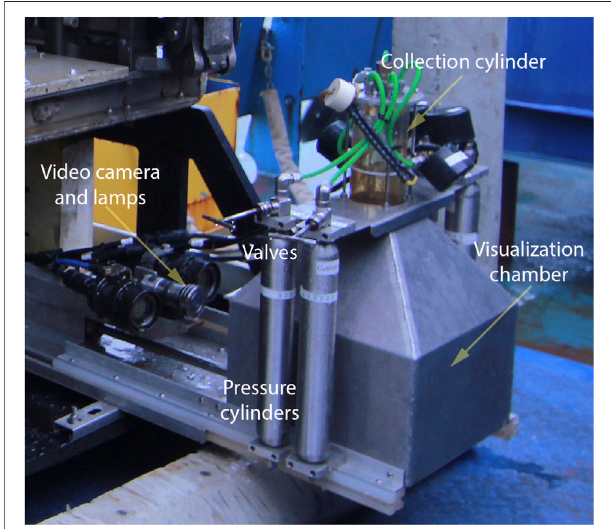
FIGURE 2 | Bubblometer on the deck: the bubblometer extended from the front of the ROV where bubbles can fl ow through the open bottom and funnel into the collection cylinder: Camera and lamps can record the inside of the chamber when the device is extended; bubbles accumulate inside the collection cylinder until valves are opened, original Fig. 4.1 (Mason et al.,